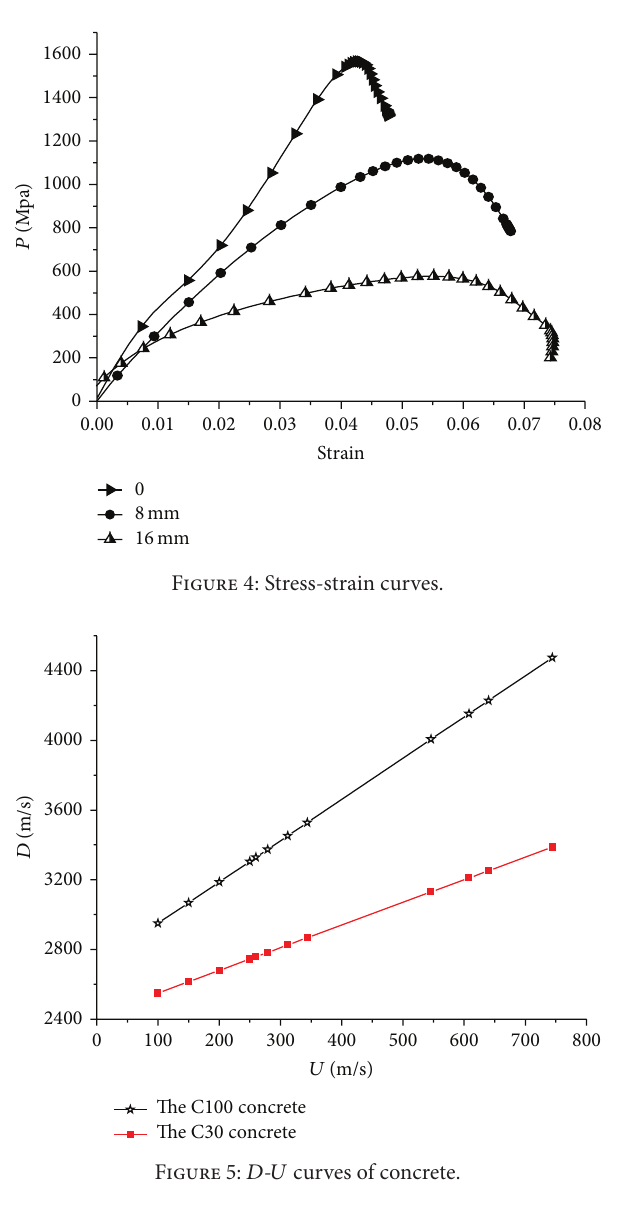
Figure 5: 𝐷 - 𝑈 curves of concrete.